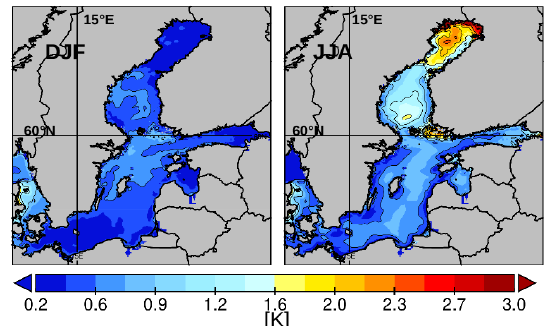
Figure 5. Intermodel standard deviation of SST for winter (December–February, DJF) and summer (June–August, JJA). The standard deviation was calculated from the six models (MOM_3nm, MOM_1nm, GETM_2nm, GETM_1nm, HBM_3nm, and